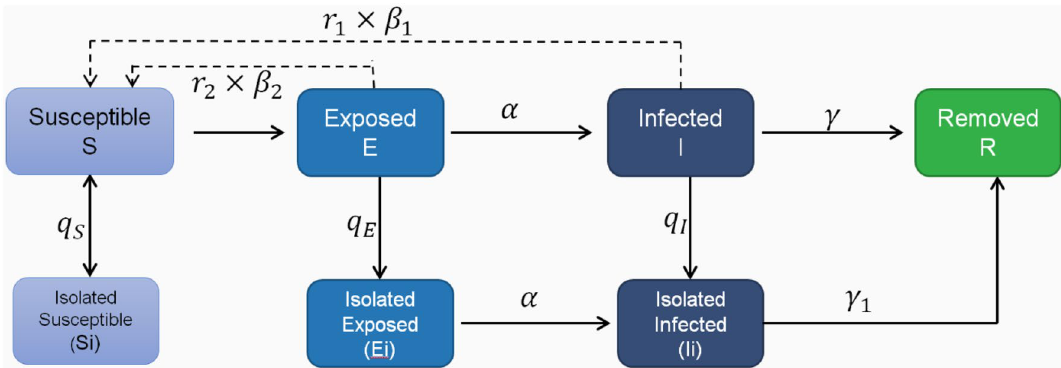
Figure 4. Schematic diagram of SEIR model considering incubation infectivity and isolation